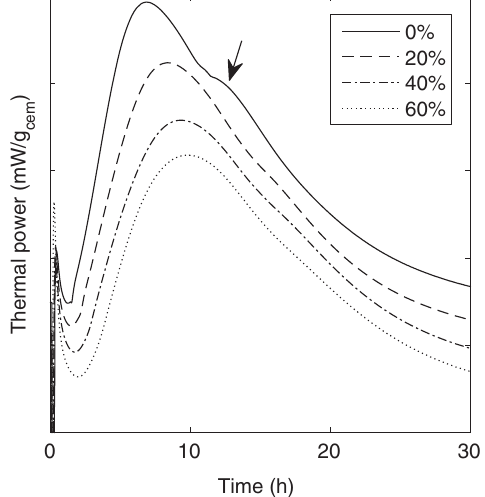
FIG. 4. The same result for cement paste with colemanite ore as in Fig. 3(g), but the hydration curves have been shifted in the y-direction to emphasize that the sulfate depletion peak at the arrow changes when the colemanite ore is